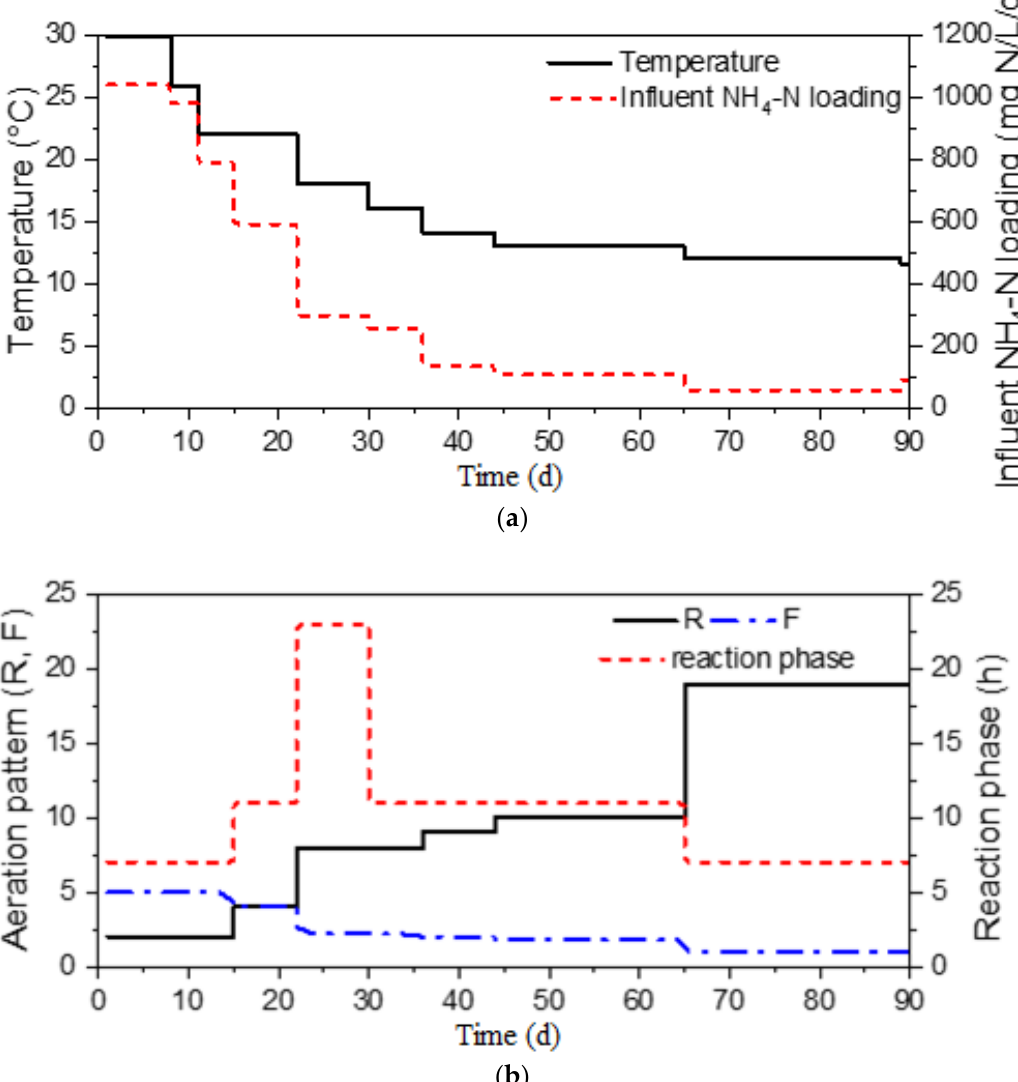
Figure 1. ( a ) Temperature and influent NH 4 -N loading; ( b ) the aeration pattern (R and F) and reaction phase